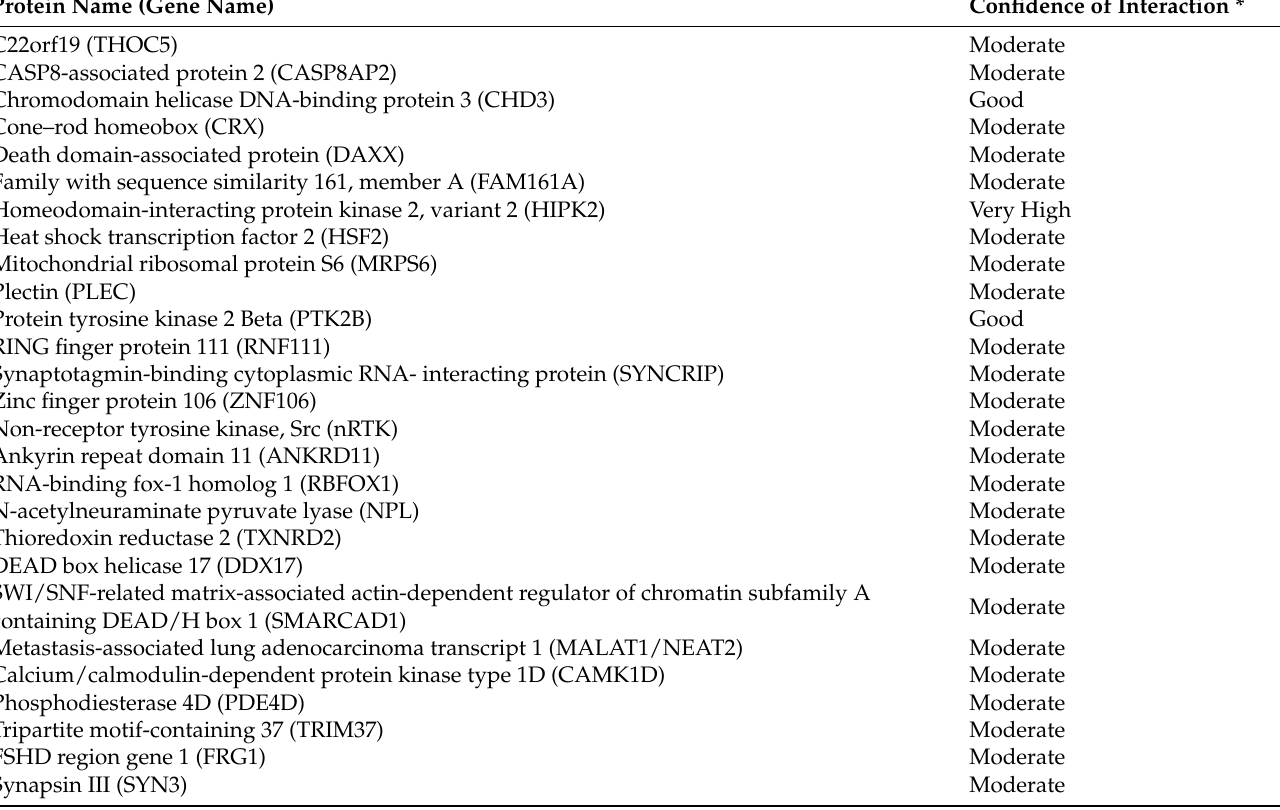
Table 1. Prey proteins identified in Y2H